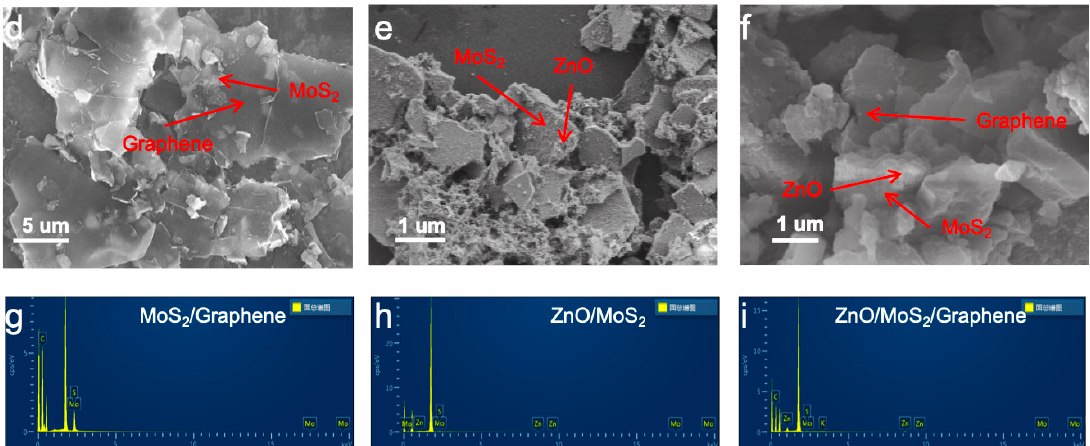
Figure 2. Morphology characteristics of the different samples. ( a ) SEM images of graphene nanoplatelets; ( b ) SEM images of MoS 2 nanoplatelets; ( c ) SEM images of ZnO nanoparticles; ( d ) SEM images of MoS 2 / graphene; ( e ) SEM images of ZnO / MoS 2 , ( f ) SEM images of ZnO / MoS 2 / graphene; ( g ) energy-dispersive X-ray spectroscopy (EDS) of MoS 2 / graphene heterostructures; ( h ) EDS of ZnO / MoS 2 heterostructures; ( i ) EDS of ZnO / MoS 2 / graphene ternary heterostructures.